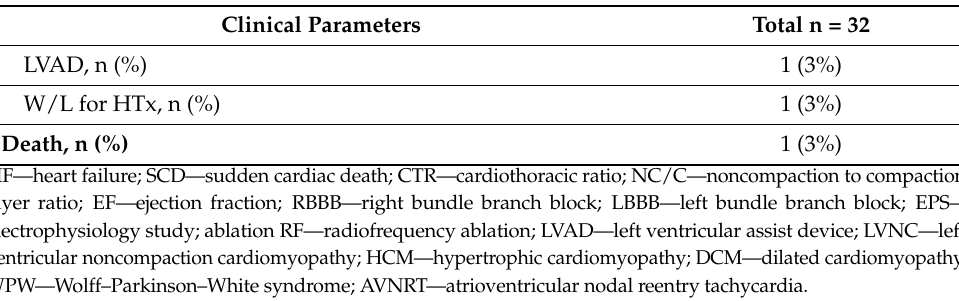
Table 2. Heart rhythm and conduction disturbances in the studied group of children.